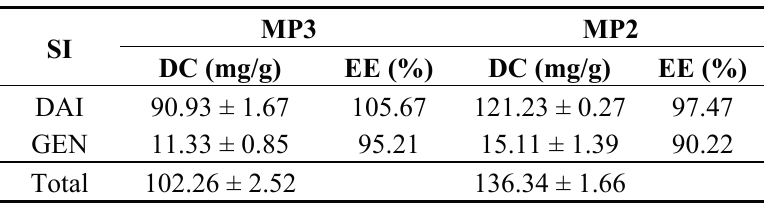
Table 1. Encapsulation efficiency (%) and drug content (mg/g) from MP2 and MP3. The results are expressed as mean ± SD. Values are means of three independent